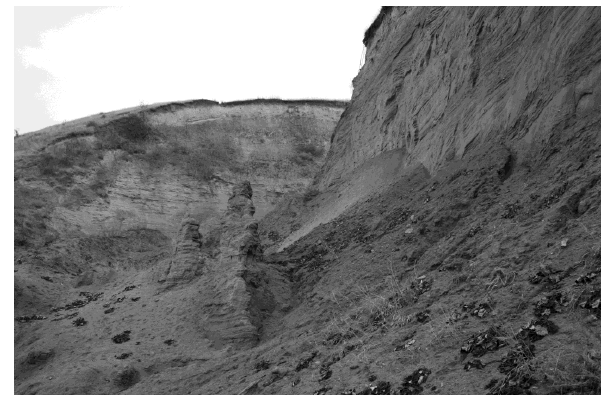
Fig. 21. Massive landfall and development of a ruiniform landscape at the base of the versants.